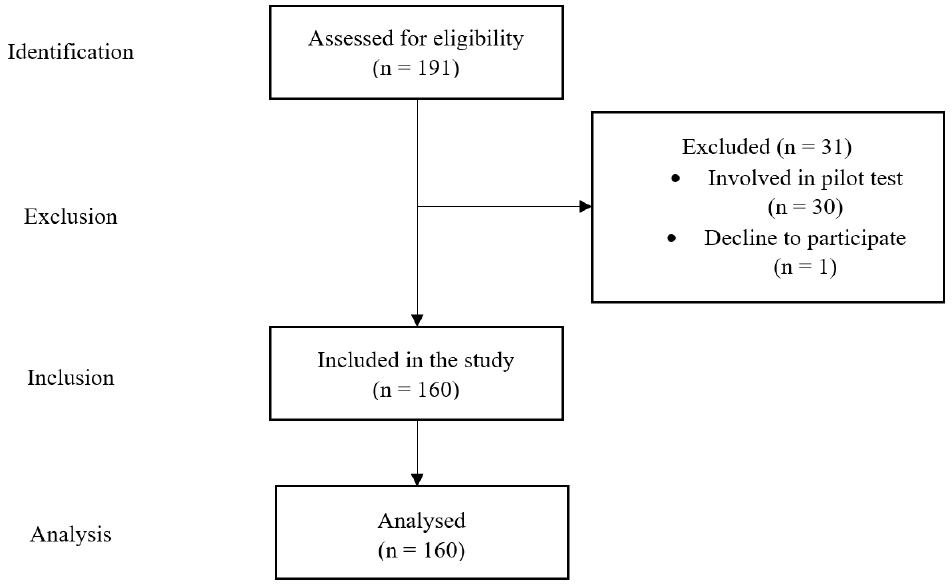
Figure 2. Flowchart describing population and sample.